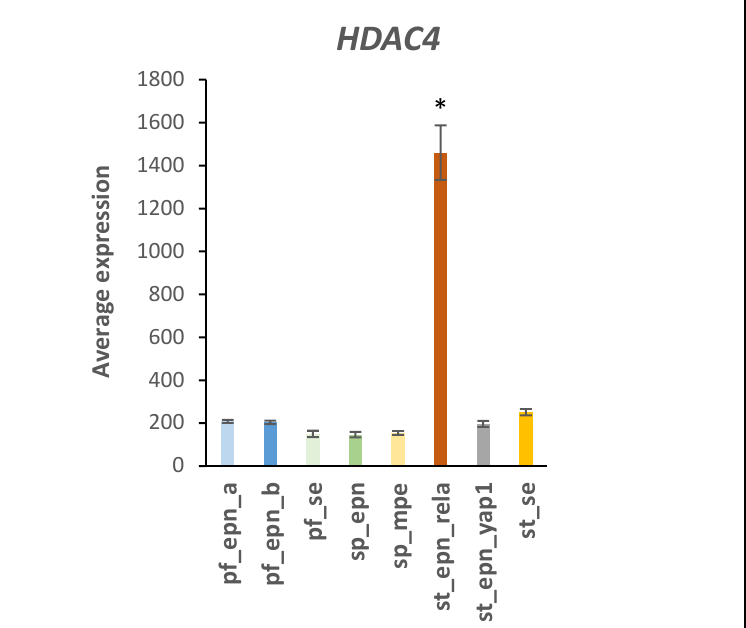
and is therefore included in the heatmap of E3 ligases (Figure 5) [17–19].